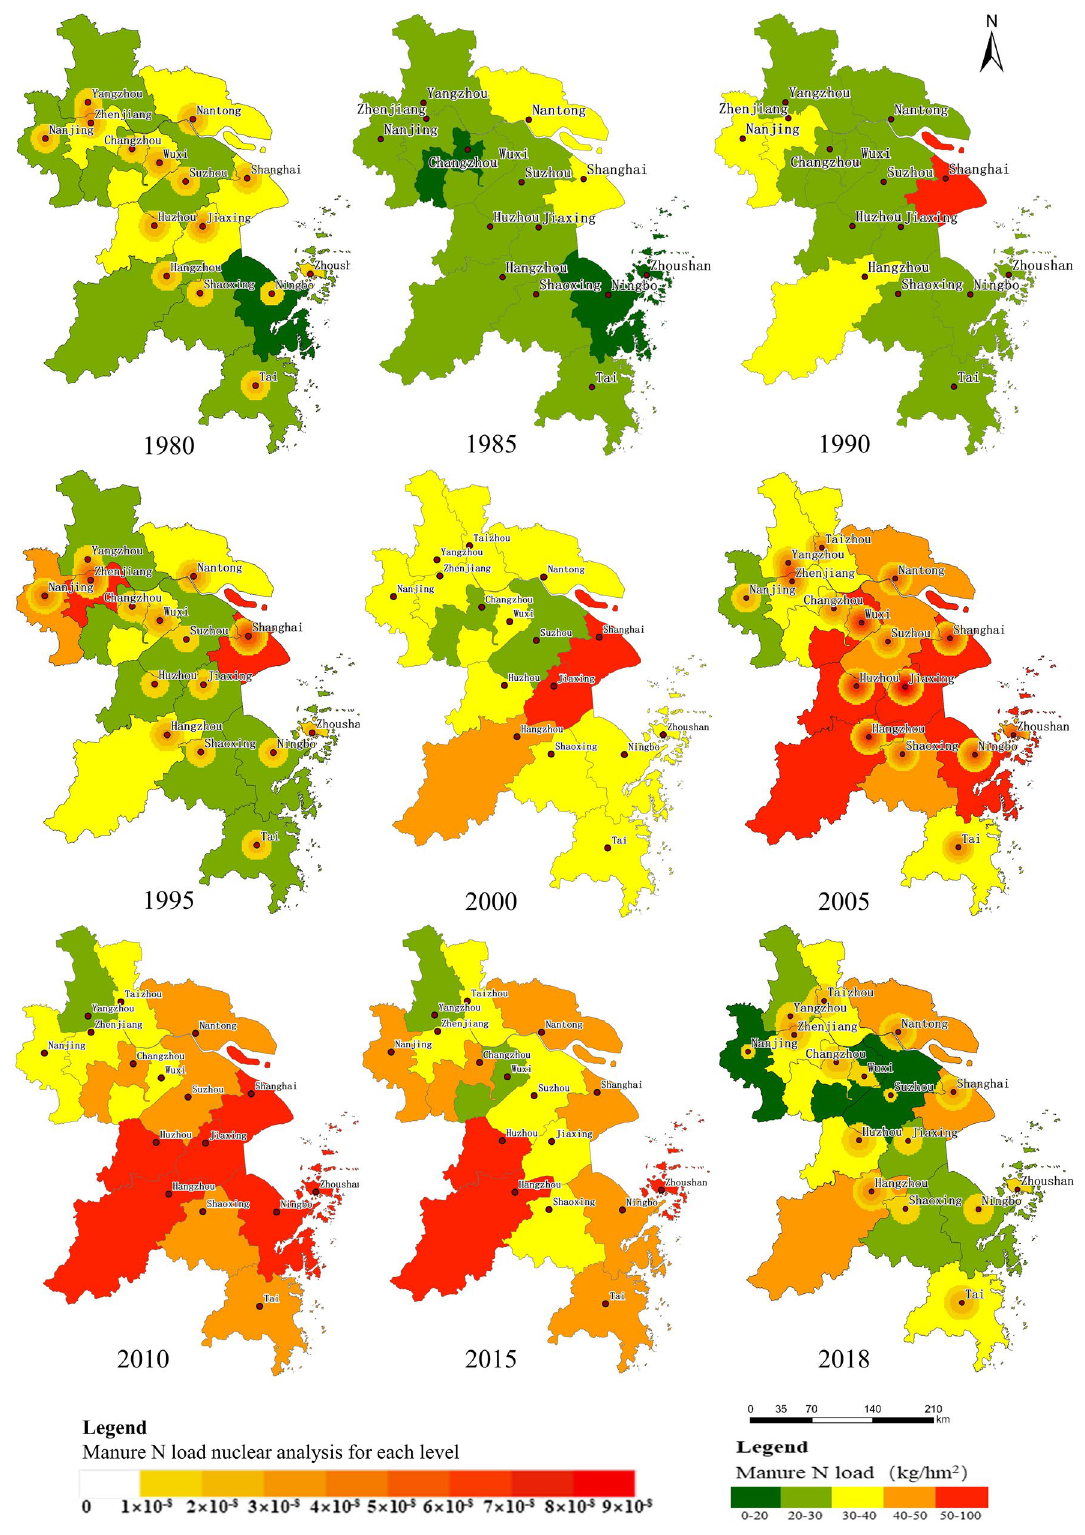
Figure 4. Spatiotemporal distribution of manure N load in the Yangtze River Delta from 1980 to